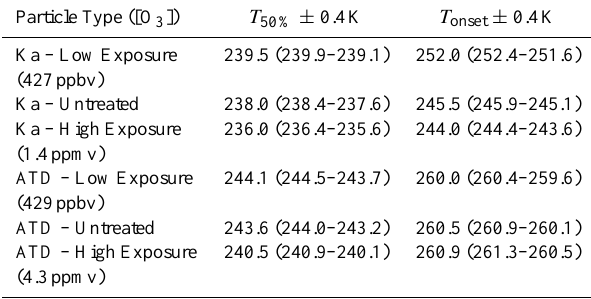
Table 2. Metrics to compare immersion freezing efficiency of Ka and ATD particles.